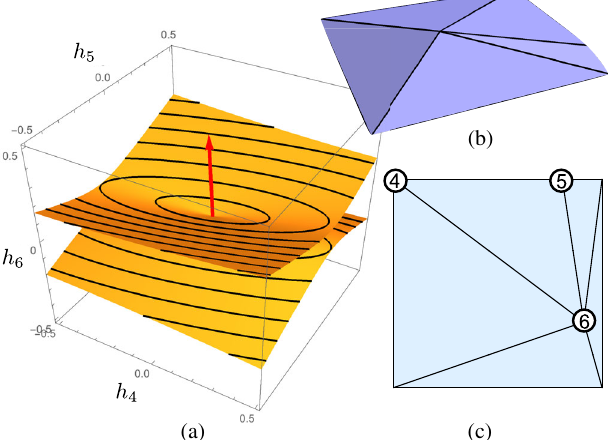
FIG. 4. (a) The configuration space of a five-fold origami vertex structure, for the crease pattern in (c), where the three unlabeled vertices are pinned to the xy plane. The axes correspond to the vertical displacements of the three vertices labeled 4 – 6. (b) The eigendeformation of the negative eigenvalue would, on its own, give the vertex positive Gaussian curvature. (c) The planar crease pattern with the three labeled vertices, 4 – 6.